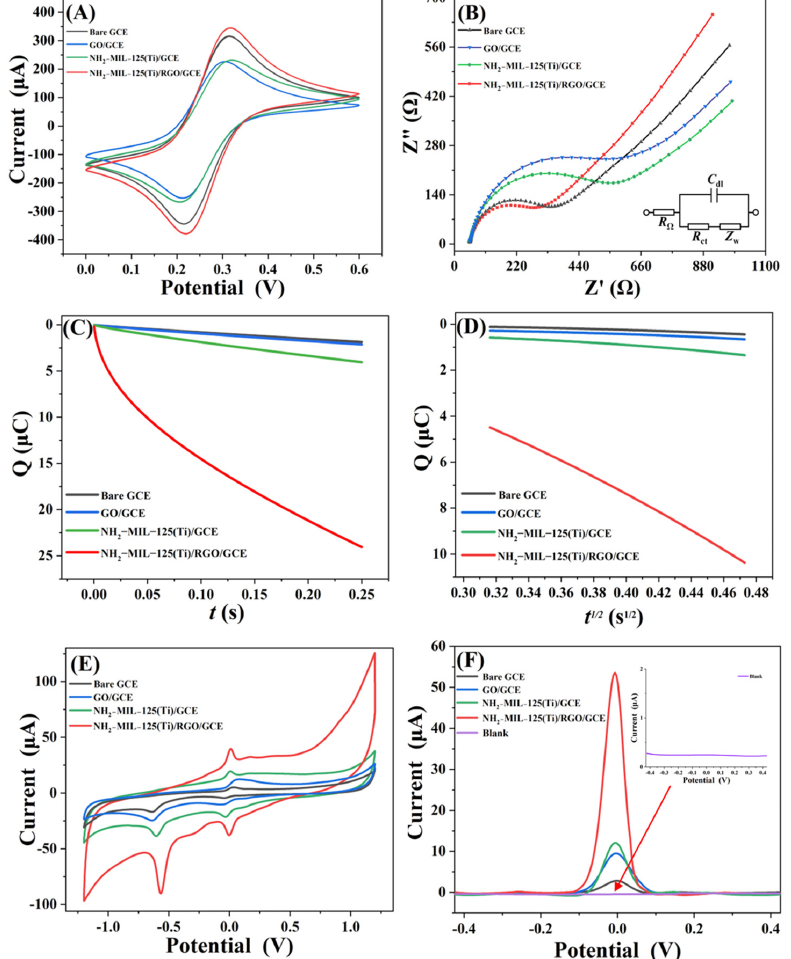
Figure 2. ( A ) CVs and ( B ) EIS of different GCEs in 5 mM Fe(CN) 63–/4– containing 0.1 M KCl; ( C ) Plot of Q~ t and ( D ) Q~ t 1/2 curves of different GCEs; ( E ) CV and ( F ) DPV responses of different GCEs for 3.6 mM FT in 0.1 M PBS. 3.6 mM FT in 0.1 M